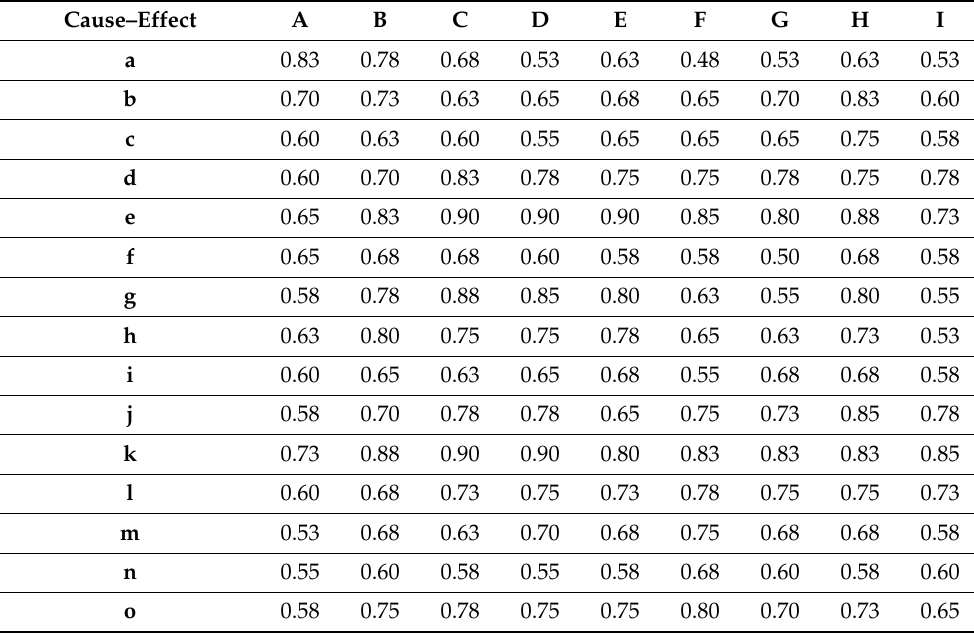
Table 5. Expertons formed from the cause–effect evaluation carried out by the group of academic experts/researchers (Matrix M2).